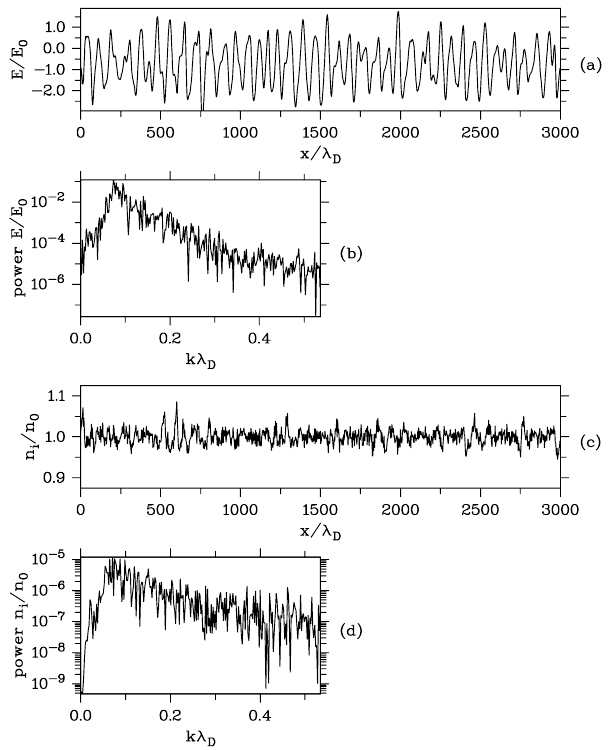
Figure 9. The same as Fig. 1 but for a dense beam; n b /n 0 = 0 . 05 , V b = 16 v the . The low-frequency power spectrum (d) peaks at the wave number of the mother